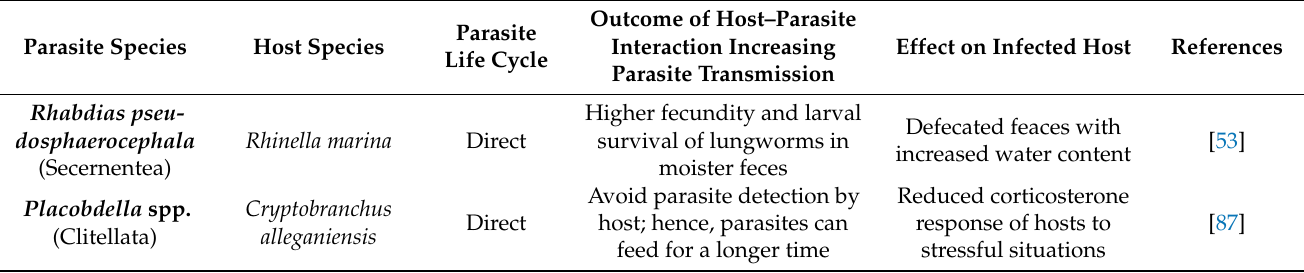
Table 3. Summary of studies reporting physiological manipulations in amphibian hosts induced by parasites from different